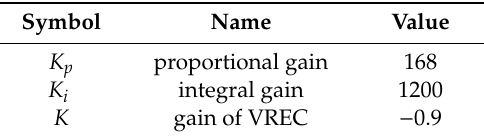
. . θ  to θ  with different parameters K : ( a ) ff erent parameters K : ( a ) amplitude– θ θ d l d to l with di Table 5. Parameters of link-side controller.